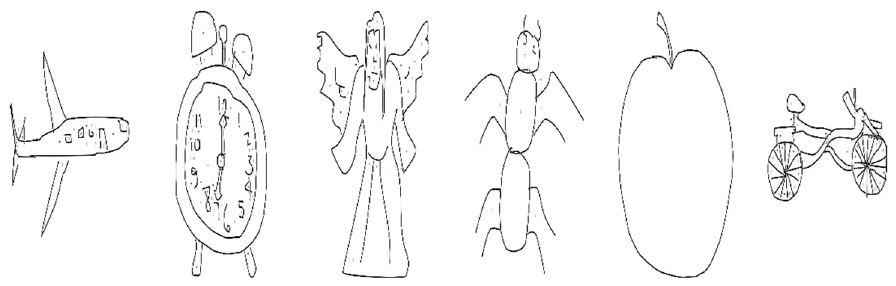
Figure 16. Extracted keypoints using SIFT for the training image of each pair.